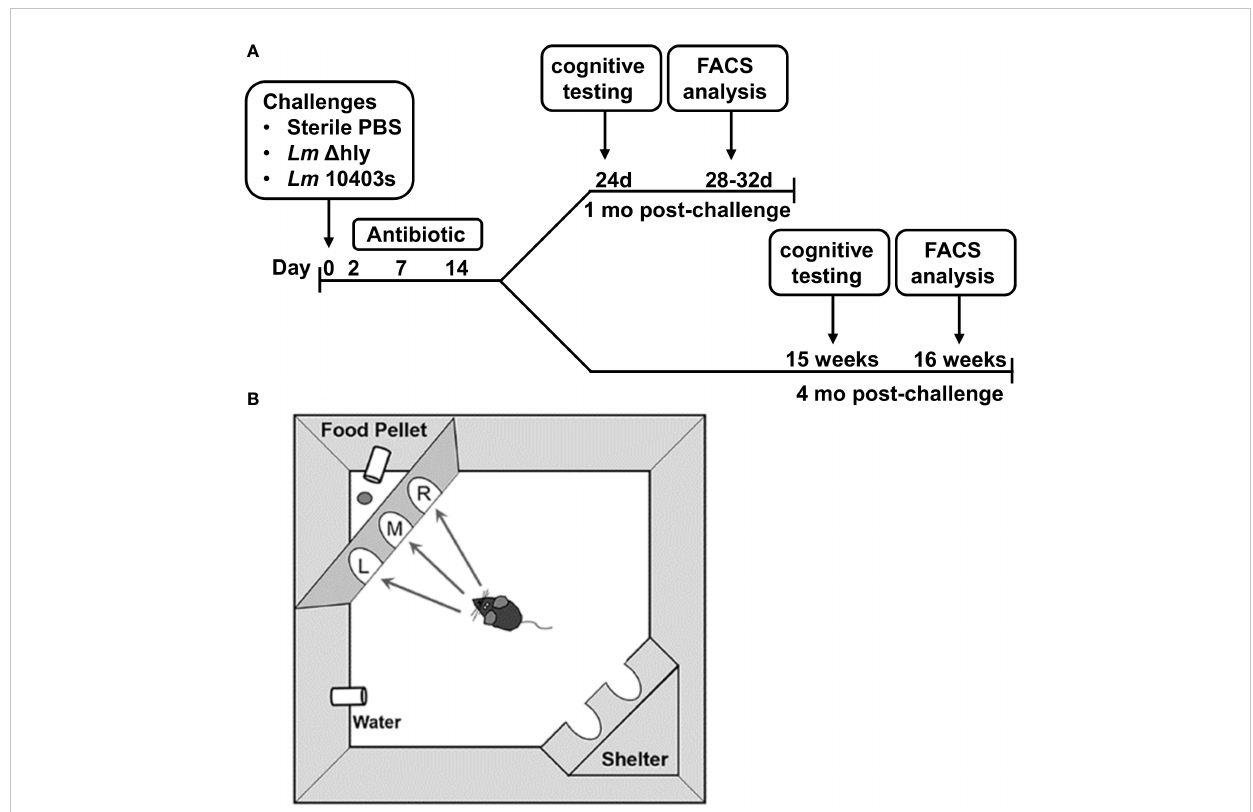
FIGURE 1 Timeline of Lm infection and graphical description of cognitive testing. C57BL/6J mice (age 2 mo) were injected i.p. with avirulent Lm D hly (3.0 x 10 7 CFU, 1 mo n=9, 4 mo n=8), neuroinvasive Lm 10403s (3.2 x 10 6 CFU, 1 mo n=11, 4 mo n=5), or with sterile PBS as uninfected controls (1 mo n=12, 4 mo n=7). All mice received antibiotics beginning 2d after injection with the indicated bacteria or sterile PBS. Mice were split into 2 cohorts with half undergoing early cognitive testing and the other half undergoing late cognitive testing. (A) Cognitive testing was performed using the Ethovision PhenoTyper with Cognition Wall (B) . During hours 1-48 (initial Discrimination period), the mouse was rewarded on a fi xed ratio schedule of 1 food pellet per 5 entries through the left most entry of the cognition wall. The algorithm is reversed at hour 49 and from hours 49-89 (reversal phase), the mouse learned to enter the right most entry to receive a reward in the same reward schedule. Movement was tracked using an IR camera located above the cage using Noldus Ethovision